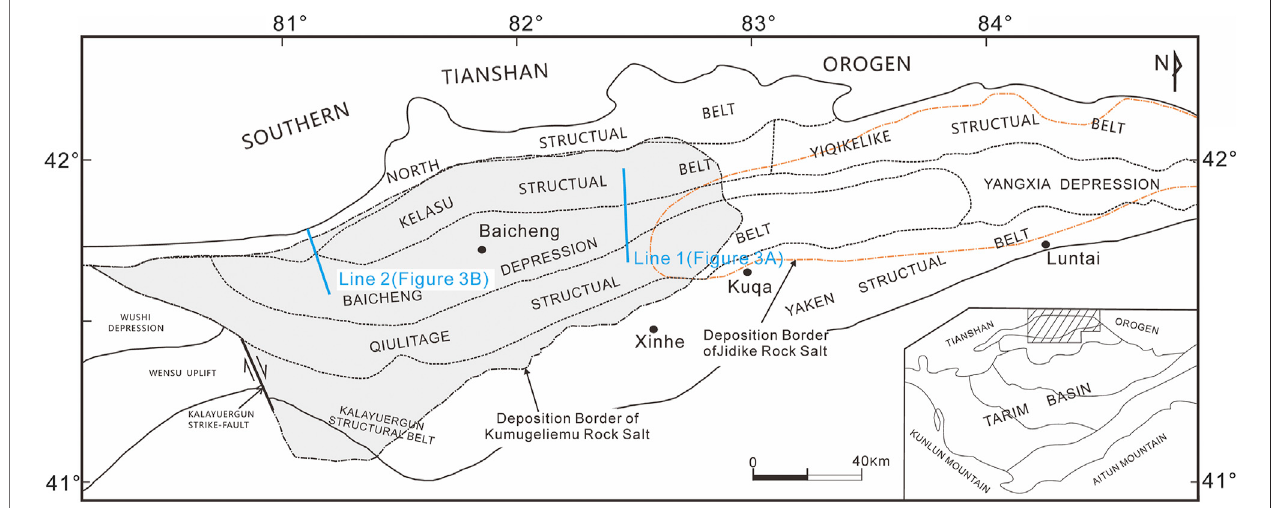
FIGURE 1 | Structural units of the Kuqa Depression, Tarim Basin.